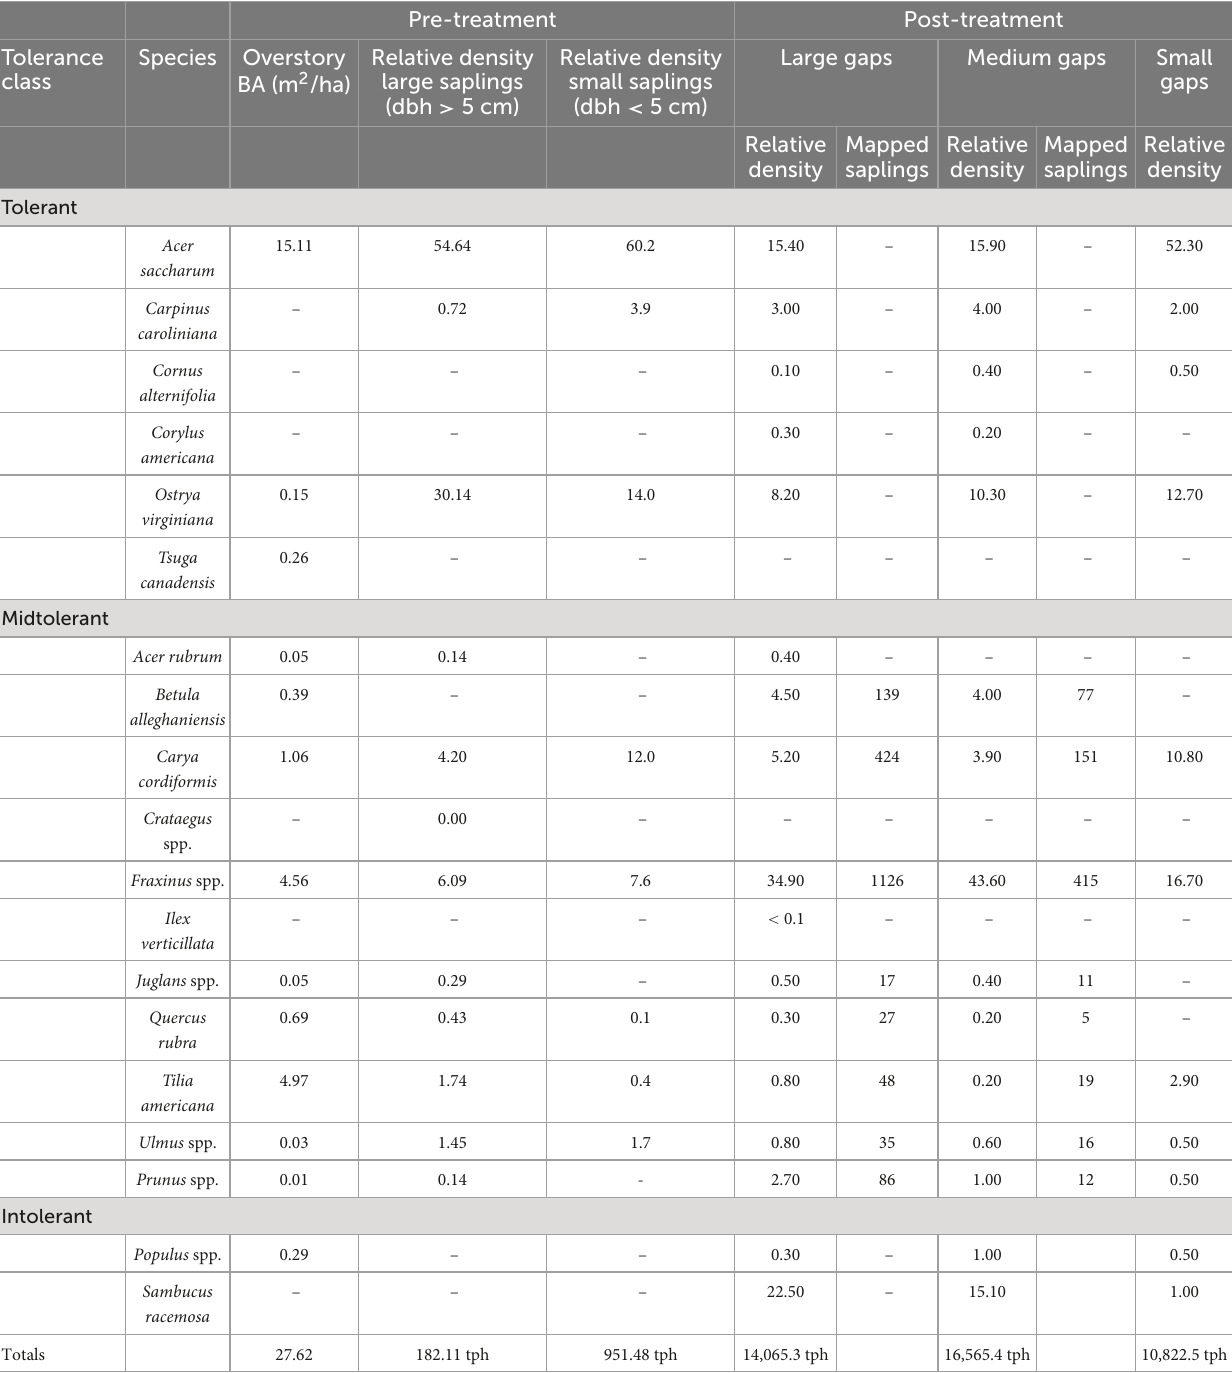
TABLE 1 Shade tolerance classes of northern hardwood species used in the Flambeau Experiment [adapted from Niinemets and Valladares (2006)], sapling relative density (2007 and 2016) in the 15 plots that received any variation of GSH treatments and number of mapped individuals (2018) in central zones of the 10 large and medium subplots receiving GSH and GSH + deer exclusion treatments where saplings were